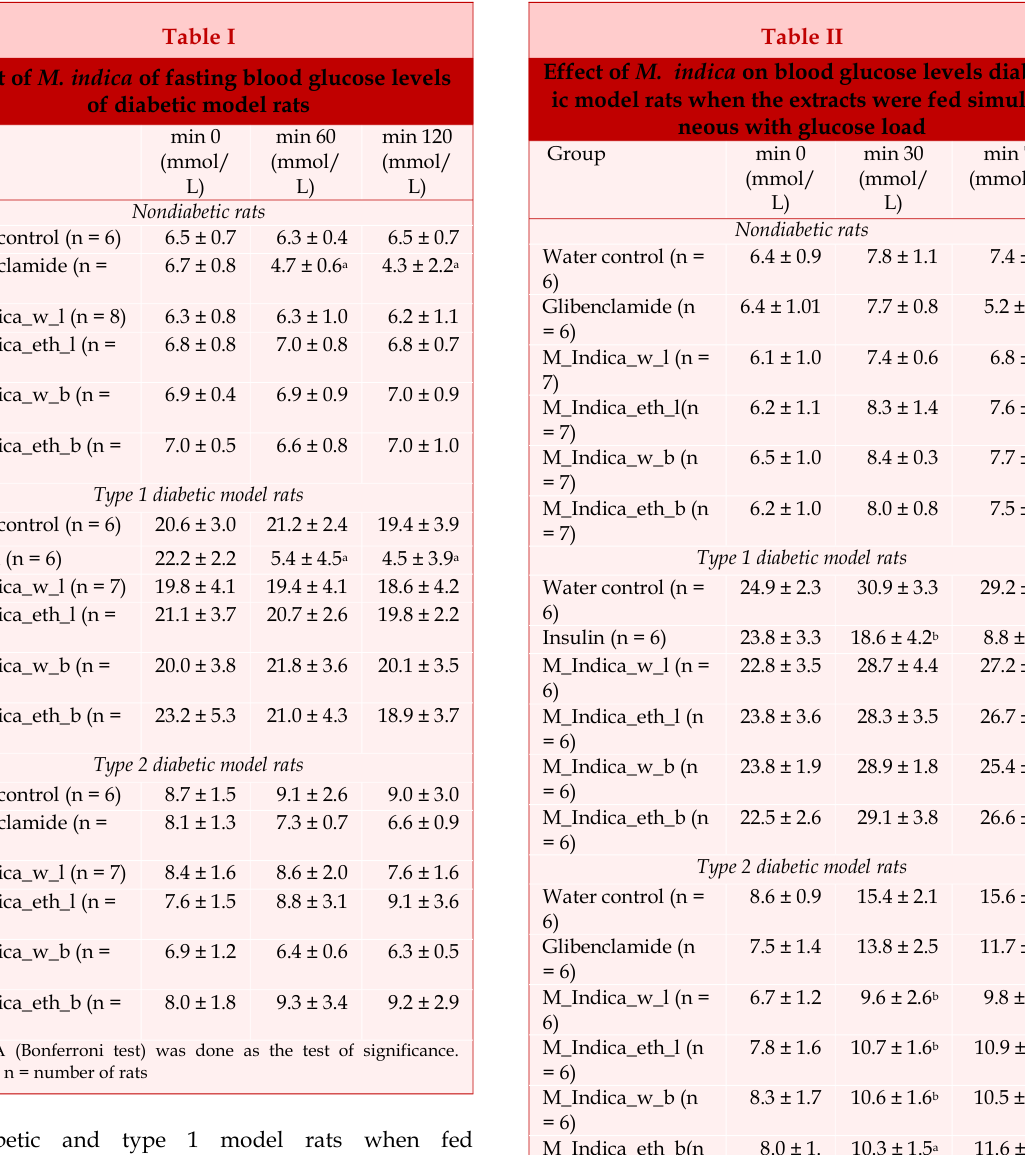
nondiabetic and type 1 model rats when fed